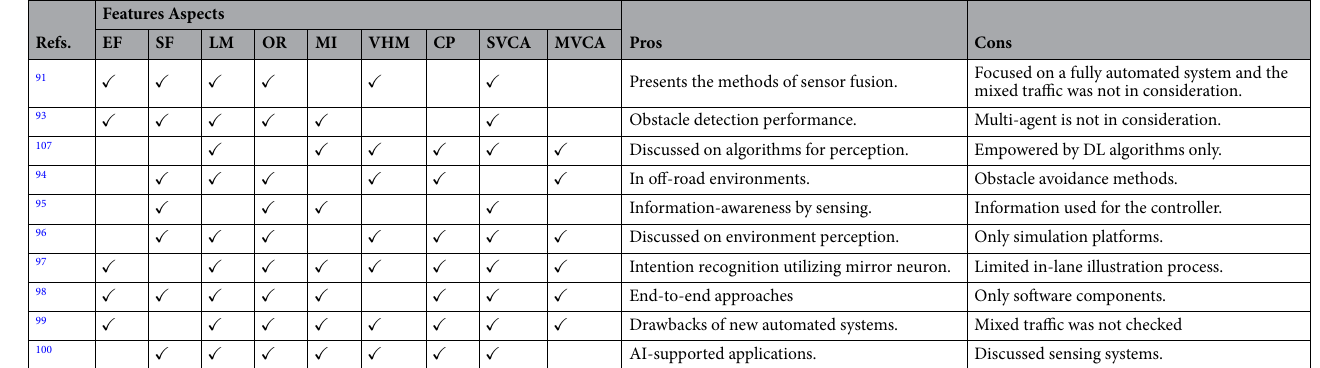
Table 4. Perception aspects of MVCCA in AVs. EF Environment fusion, SF Sensor fusion, LM Localization and mapping, OR Object refinement, MI Maneuver illustration, VHM Vehicle health monitoring, CP Cooperative perception, SVCA Single vehicle collision avoidance, MVCA Multiple vehicle